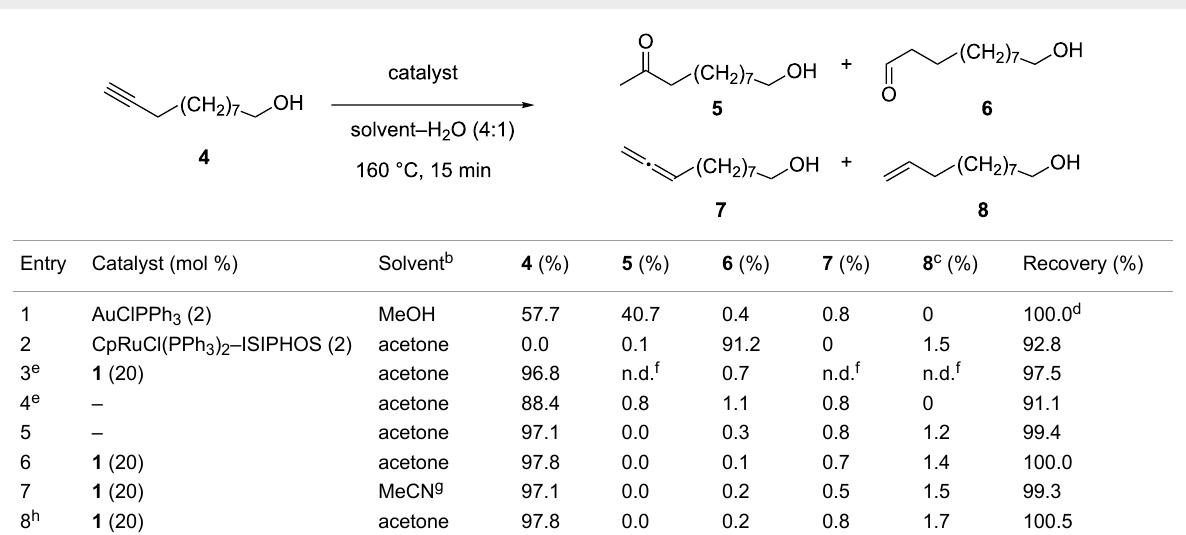
Table 1: Hydration experiments with 10-undecyn-1-ol ( 4 ). a